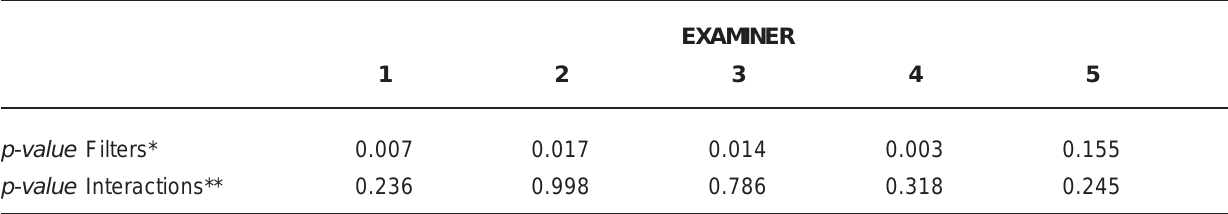
TABLE 2- p-value for the comparisons among the values of each image filter of each examiner and the p-value for the interaction between the regions and the filters